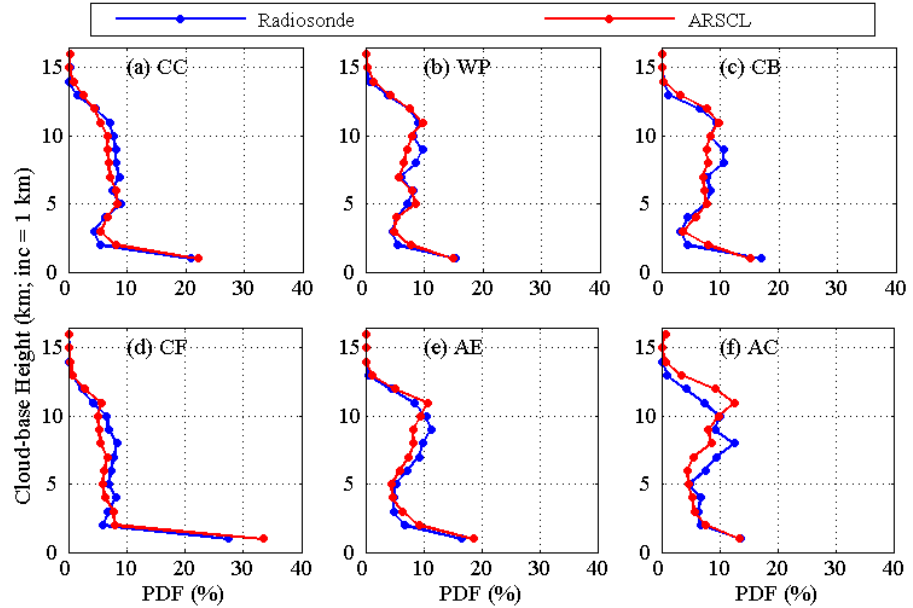
Figure 11. Probability density function (PDF) of cloud-base height derived from radiosonde (blue line) and ARSCL (red line) in the synoptic patterns of: CC ( a ); WP ( b ); CB ( c ); CF ( d ); AE ( e ); and AC ( f ) during 2001–2010 at the SGP site. The space interval is 1 km in each panel.